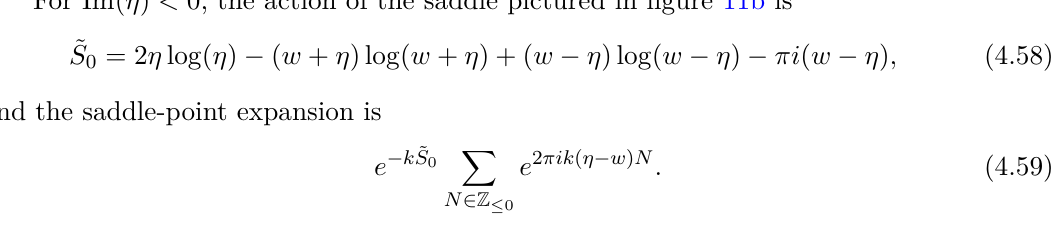
Figure 12. Shifted transmitted contour. When Re( η ) < w , one must sum over contours with r ( L ) → r ( L ) − 2 πiN in order to reproduce the semi-classical limit of the transmission coefficient. this form, where r ( L ) → r ( L ) − 2 πiN , together with the N -fold wrapping, we obtain the required lattice of actions for eq.